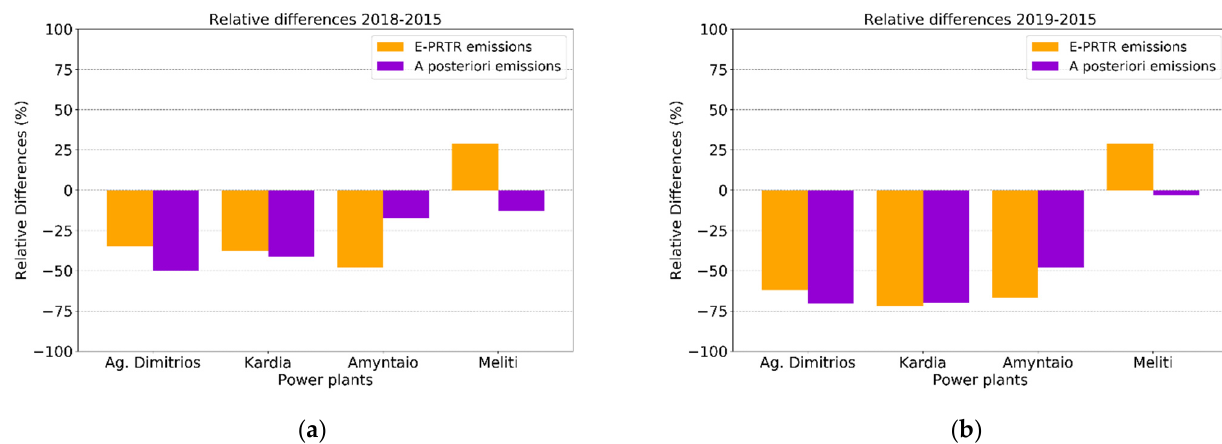
Figure 8. Relative differences of E-PRTR annual reported emissions (orange bars) and the assimilated annual emissions (purple bars) ( a ) for 2018 and ( b ) 2019, both with respect to E-PRTR 2015 reported emissions.